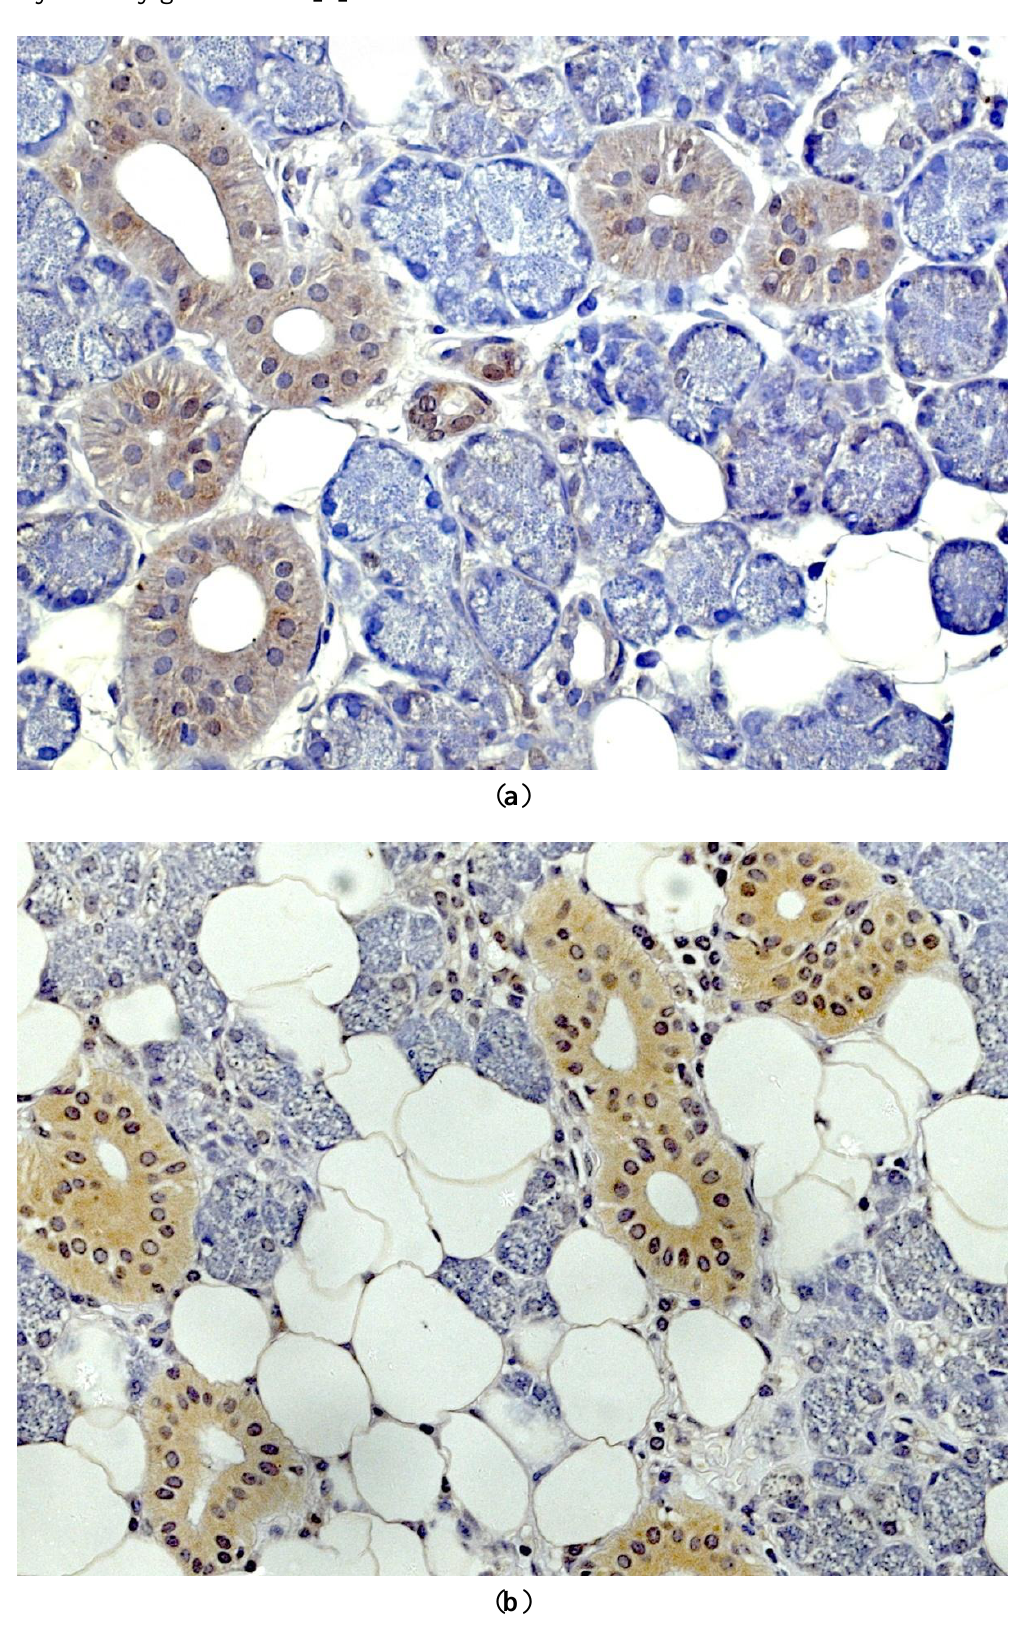
Figure 1. Immunostaining (brownish color) for ( a ) hBD-1, ( b ) hBD-2 and ( c ) hBD-3 in healthy salivary gland tissue